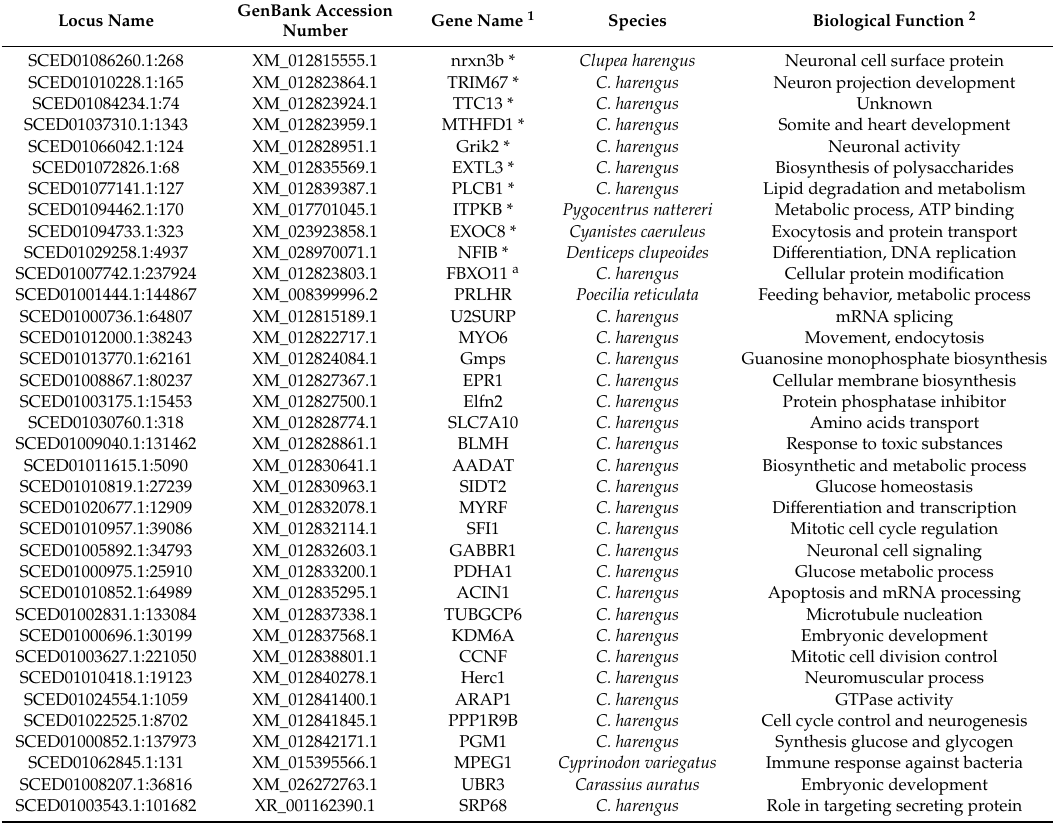
Table 4. Summary of the gene functions and annotation based on the reference genomes available in the public database of the putatively adaptive panel of the SNP loci of T. ilisha